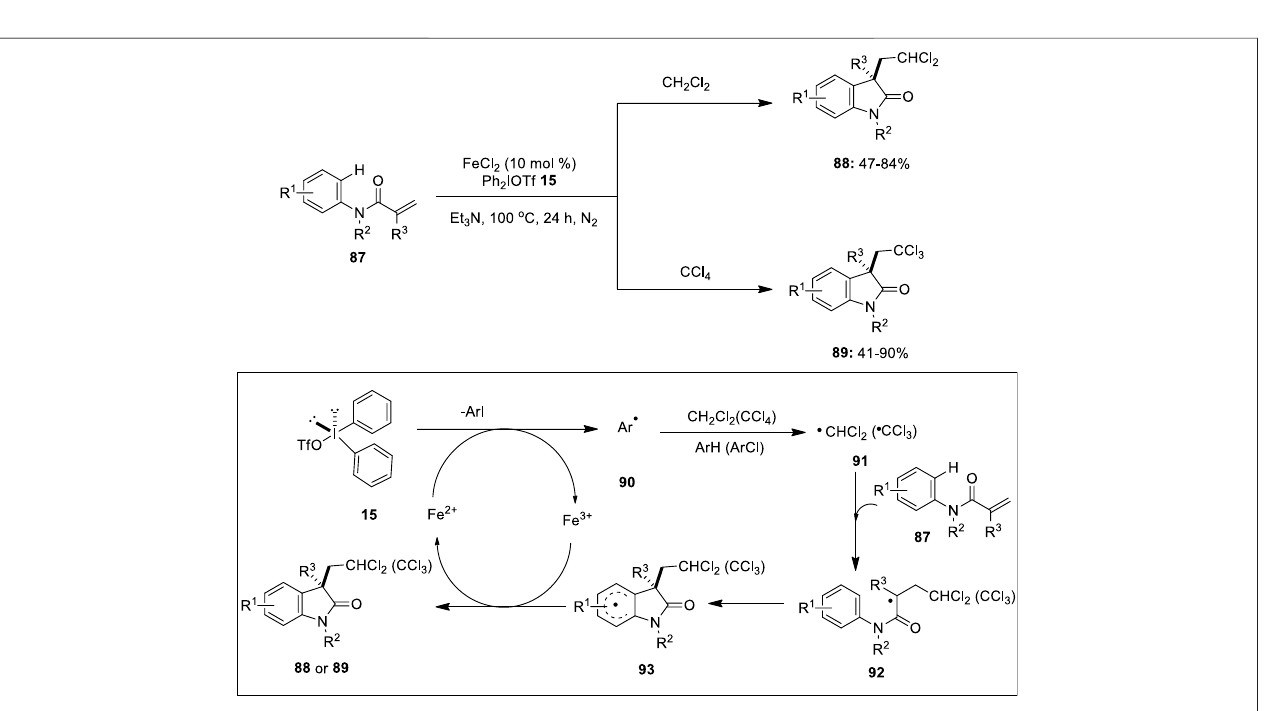
Frontiers in Chemistry |